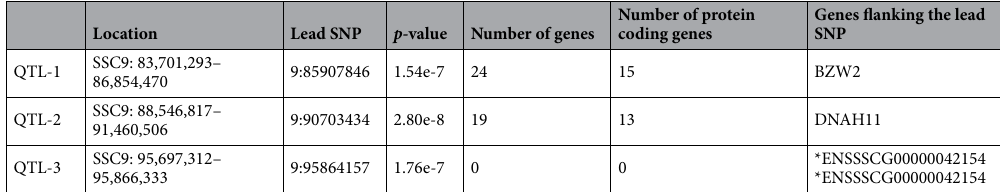
Table 1. Description of QTL blocks as defined by linkage disequilibrium. *Flanking genes for lead SNP in QTL-3 are located outside the QTL.